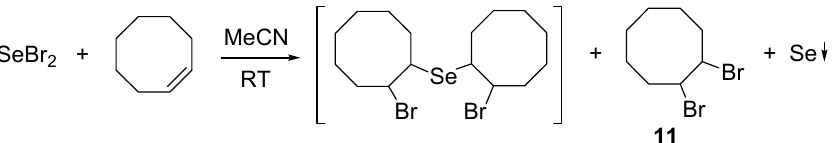
Figure 1. ORTEP molecular structure of selanes 9a and 10a (50% thermal ellipsoid probability).